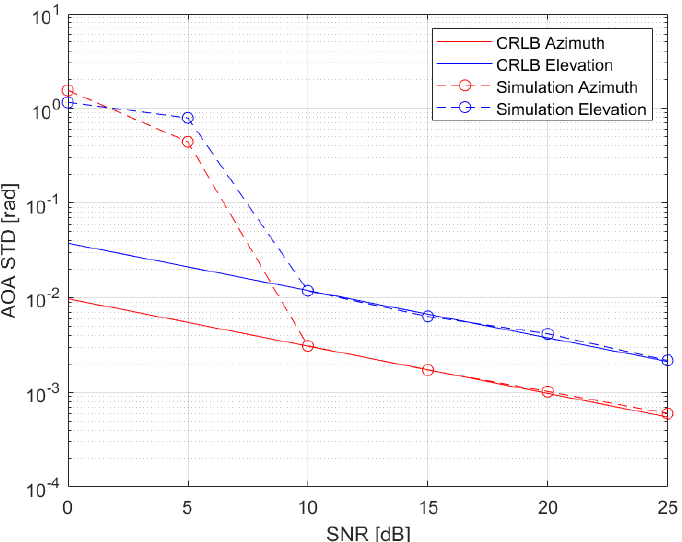
the CRLB while the dashed lines with circles show the simulation results. It can be seen are much higher than the bound. Figure 1. Antenna motion during a single measurement. Figure 1. Antenna motion during a single measurement.